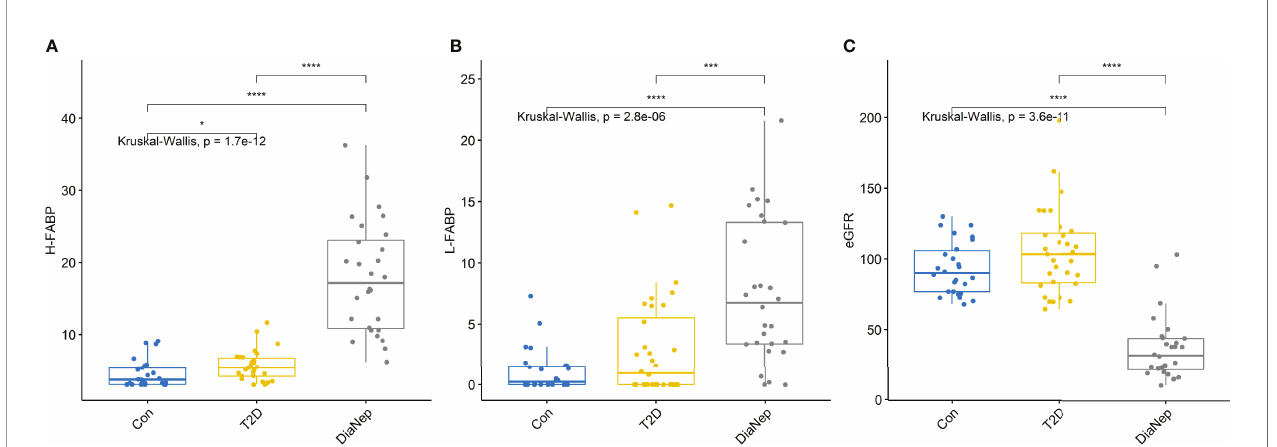
FIGURE 1 | (A) Serum H-FABP was signi fi cantly higher in the T2D and DN patients with respect to control participants. (B) Serum L-FABP was also signi fi cantly higher in the DN patients with respect to control participants. However, although the L-FABP was signi fi cantly different between the T2D and DN patients, there was no difference in L-FABP between the control and T2D participants. (C) eGFR for control and T2D participants were not signi fi cantly different. However, there was almost a 70% decrease in eGFR in the DN patients with respect to control and T2D participants. Stars of signi fi cance *p<0.05, ***p<0.001, and